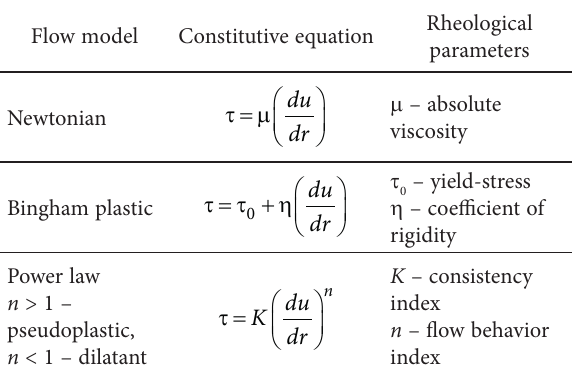
Table 1. Engineering flow models have been used for all tests described in this paper Flow